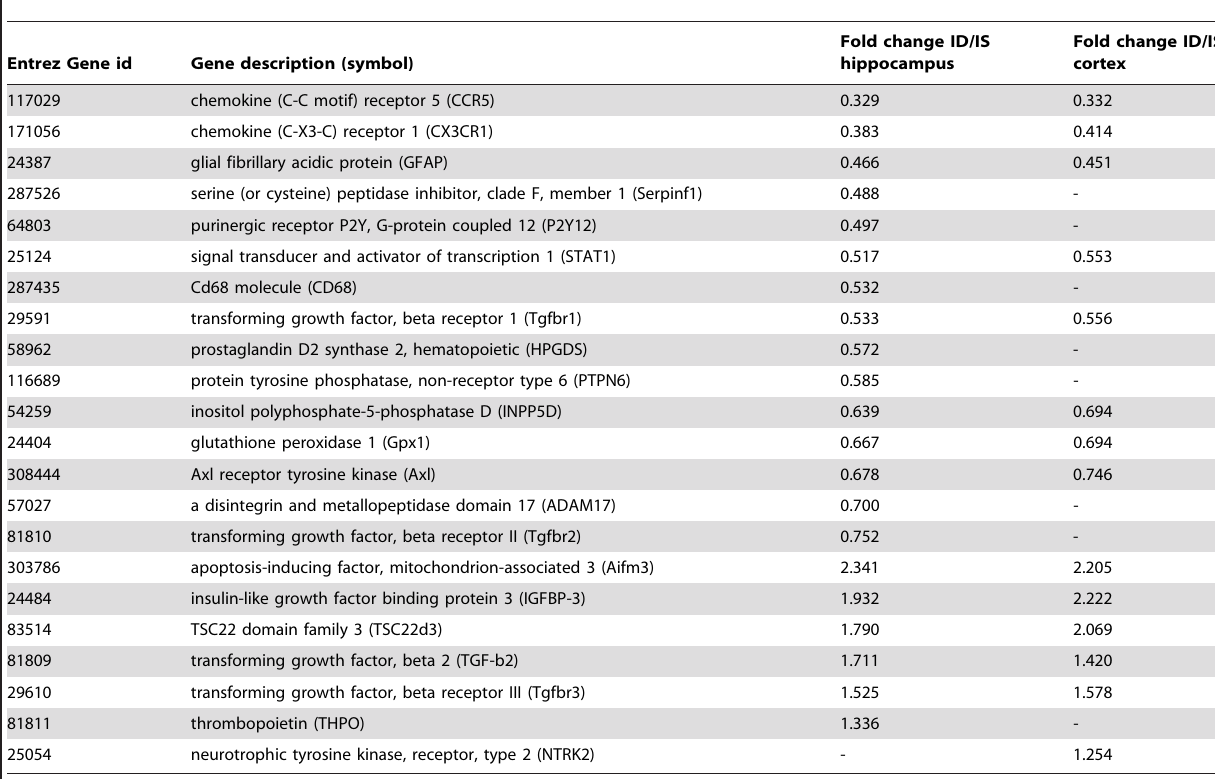
Table 4. Fold changes of significantly different genes on microarrays which are mentioned in the discussion.